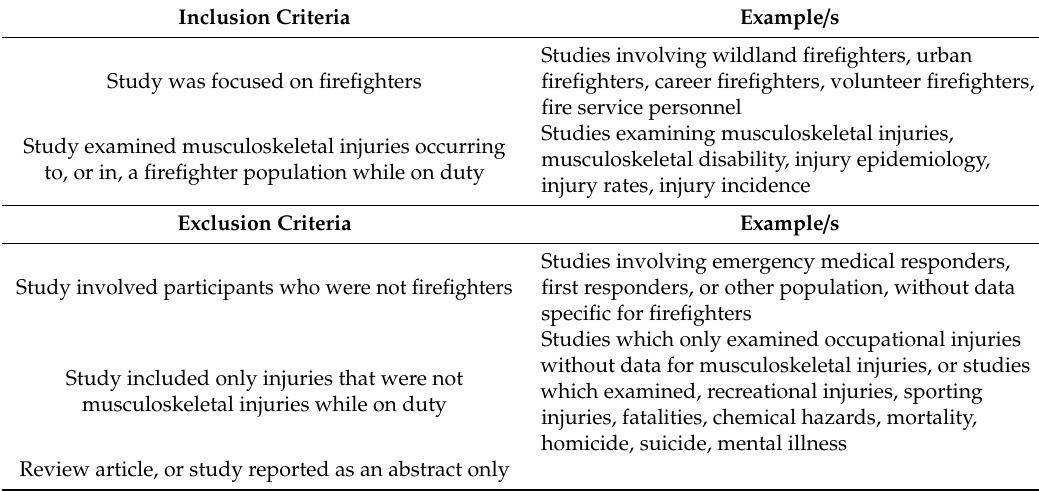
Table 2. Inclusion and exclusion criteria and examples of excluded